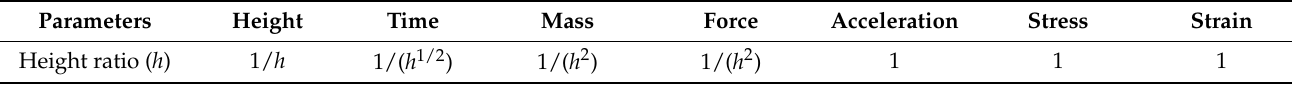
Table 3. Reduction rates of parameters depending on the height ratio ( h ) by similitude